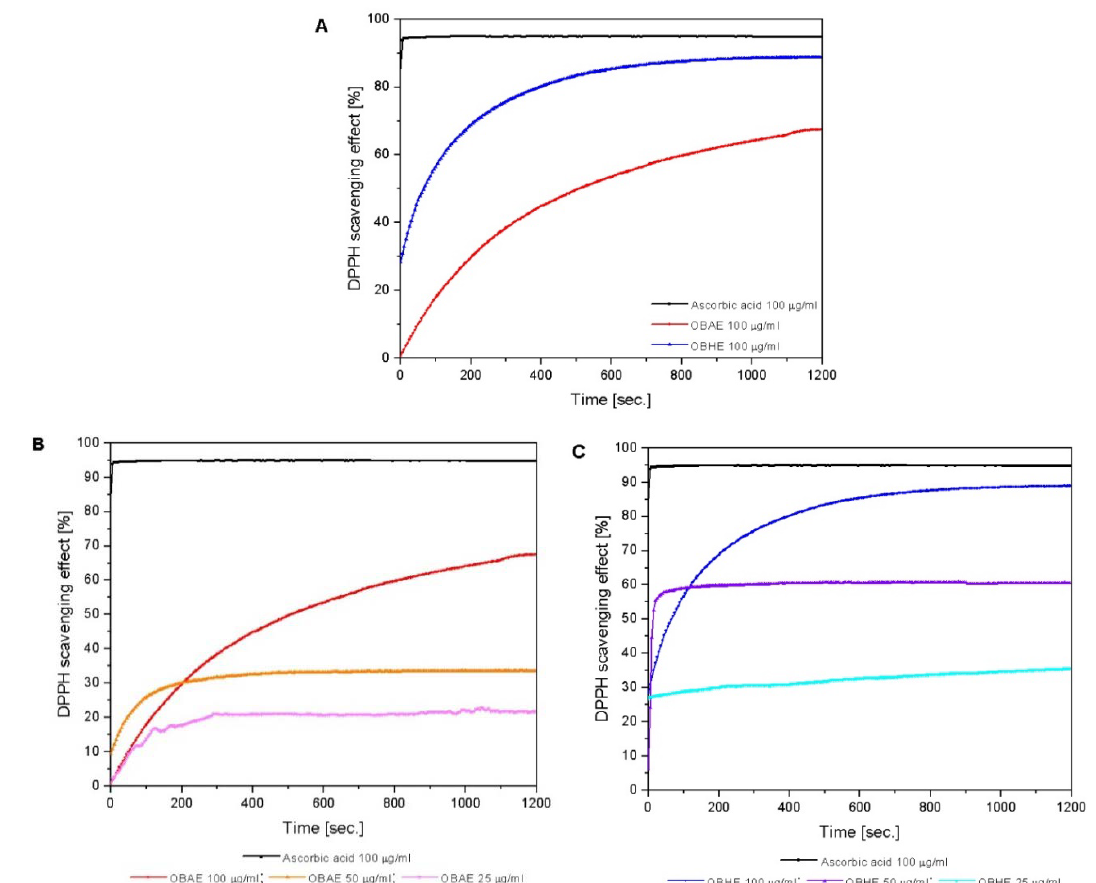
Figure 1. Free radical scavenging activity of hydro-alcoholoc basil extracts, ( A )—OBAE (100 μg/mL) and OBHE (100 μg/mL) stock solution vs. ascorbic acid (AA—100 μg/mL); ( B )—hydro-alcoholic extracts from basil aerial—OBAE (100, 50 and 25 μg/mL) vs. AA (100 μg/mL); ( C )—hydro-alcoholic extracts from basil leaves—OBHE (100, 50 and 25 μg/mL) vs. AA (100 μg/mL).